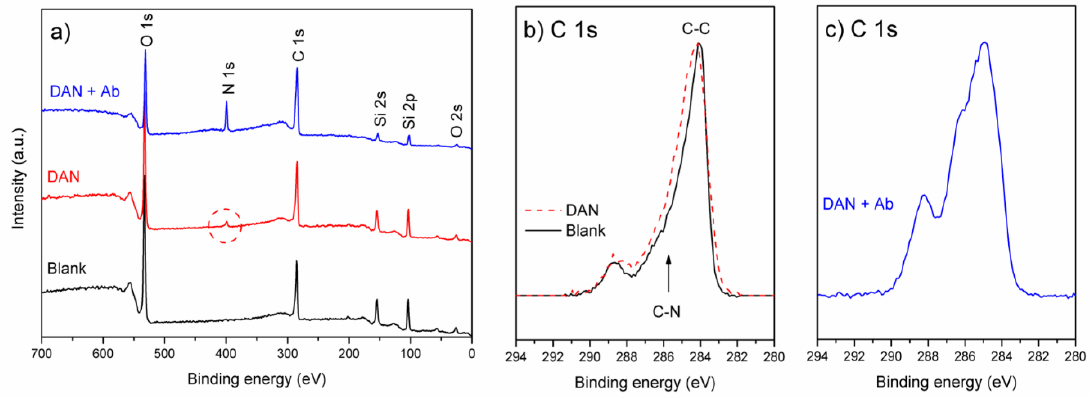
Figure 3. XPS spectra of successively functionalized graphene on SiO 2 : ( a ) Survey spectra showing the appearance of N 1s signal following surface modification with DAN and screening of Si substrate signal; ( b ) comparison of normalized C 1s peak for blank graphene and DAN modified samples showing broadening of C-C component / increase in the region associated with C-N components; ( c ) a significant change in the shape of normalized C 1s signal following attachment of antibody.